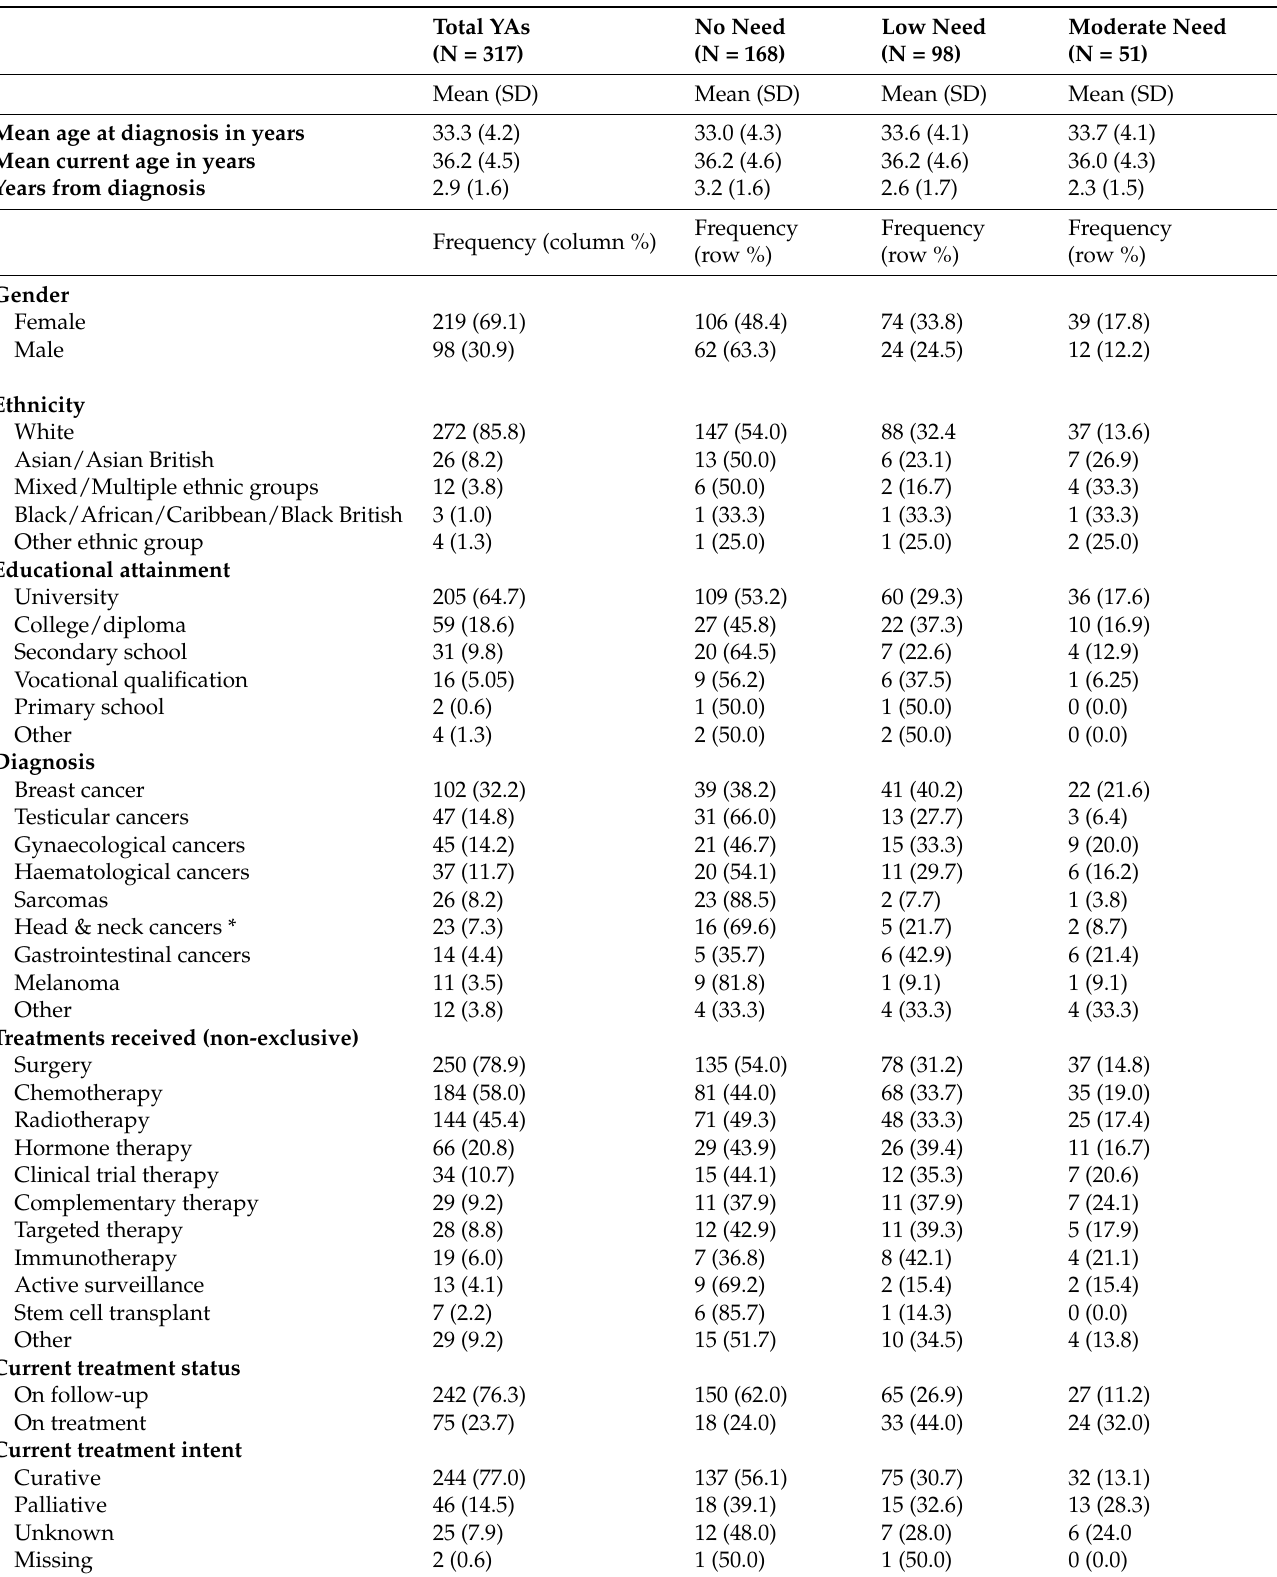
Table 1. Summary of patient-reported demographic and clinical characteristics in total sample and stratified by level of supportive care